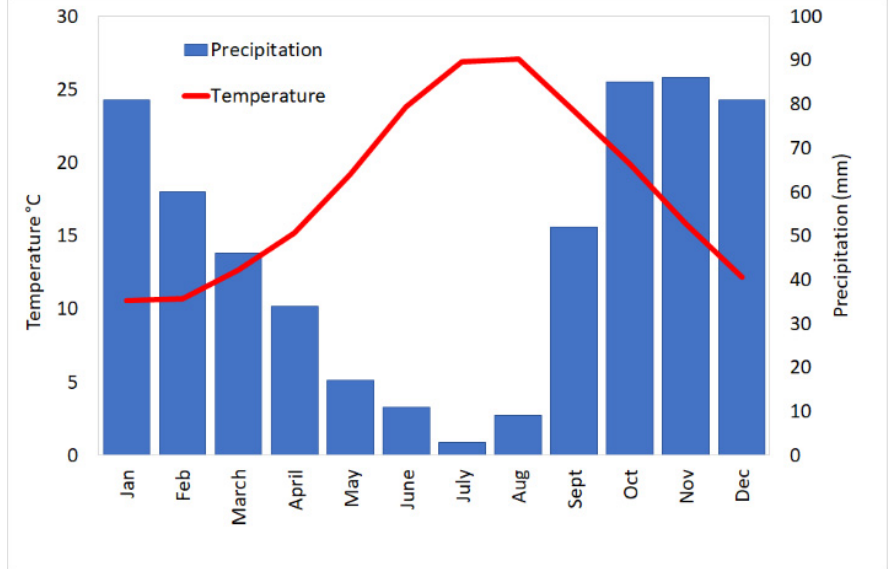
Figure 2. Weather data from meteorological station of Augusta. Mean monthly precipitation (mm) and mean monthly temperature (°C).